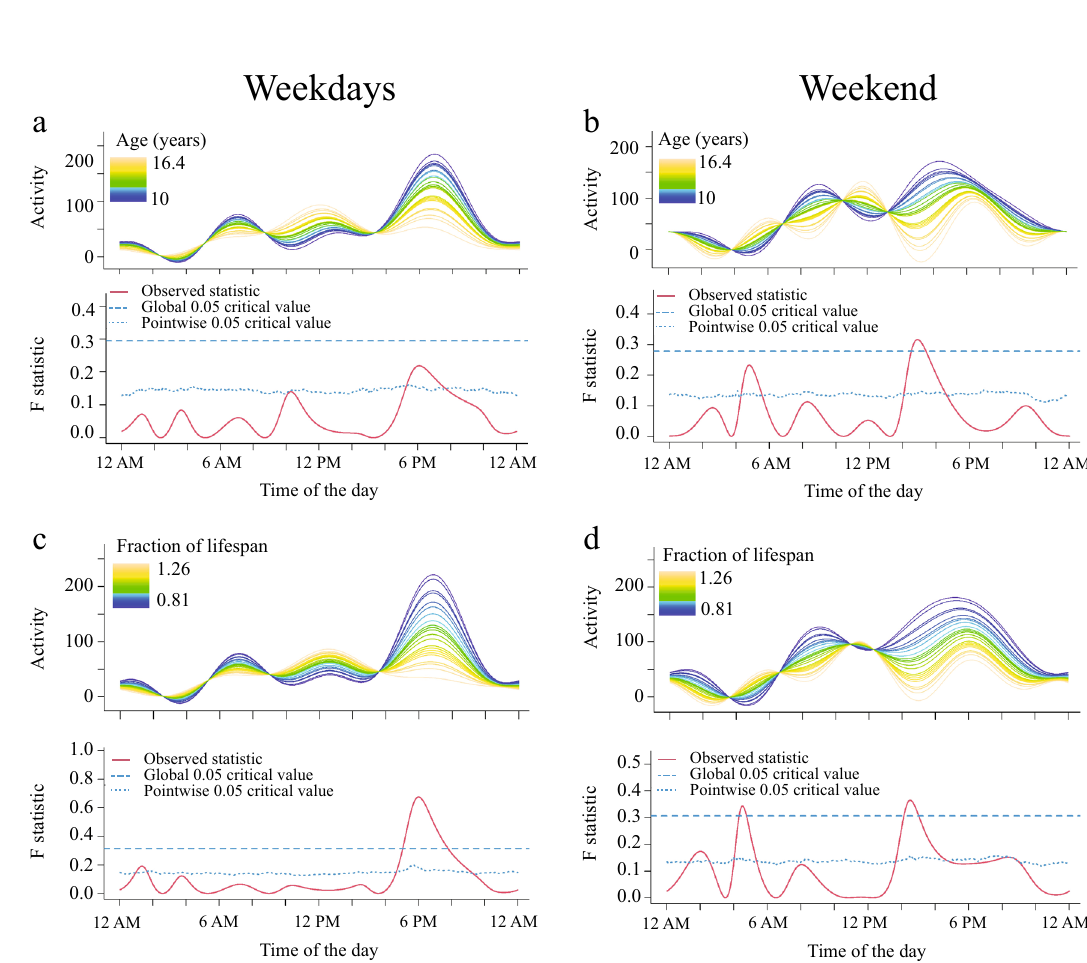
Figure 1. Relationship between age ( a,b ) and fraction of lifespan ( c,d ) on activity levels in senior dogs. For each figure, the upper graph illustrates activity over time for different levels of the variables analyzed and the lower graph indicates the level of significance of the differences. When the observed statistic (red line) is above the test of significance set at 0.05 (blue lines) it indicates significant differences between different levels of the variable. The dashed and the dotted lines indicate global and point-wise test of significance respectively. Older dogs showed lower activity levels between 5.00 and 8.00 PM on weekdays and between 2 to 5 PM on weekends. Also, during weekend nights, older dogs were more active around 5